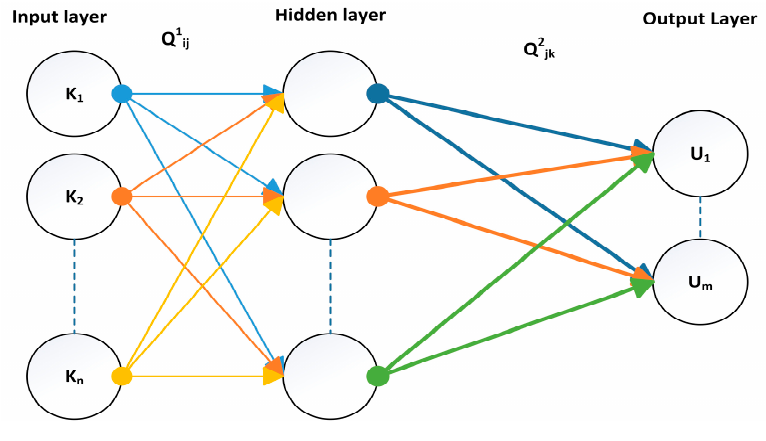
Figure 3. Standard MLP model.